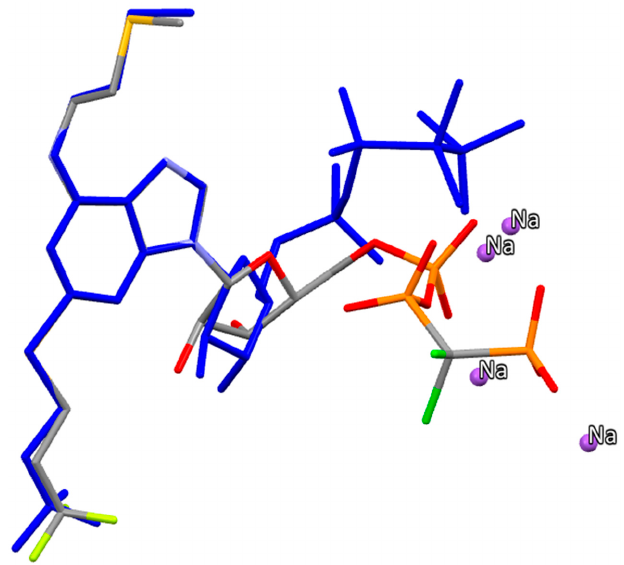
Figure 4. Molecular superimposition of the Becke3LYP optimized molecular structure of cangrelor (blue) and its sodium salt cangrelor tetrasodium (color by connected atoms, carbon gray, oxygen red, fluorine and chlorine green, sulfur yellow, phosphorus orange). For simplicity, the hydrogen atoms are not shown.